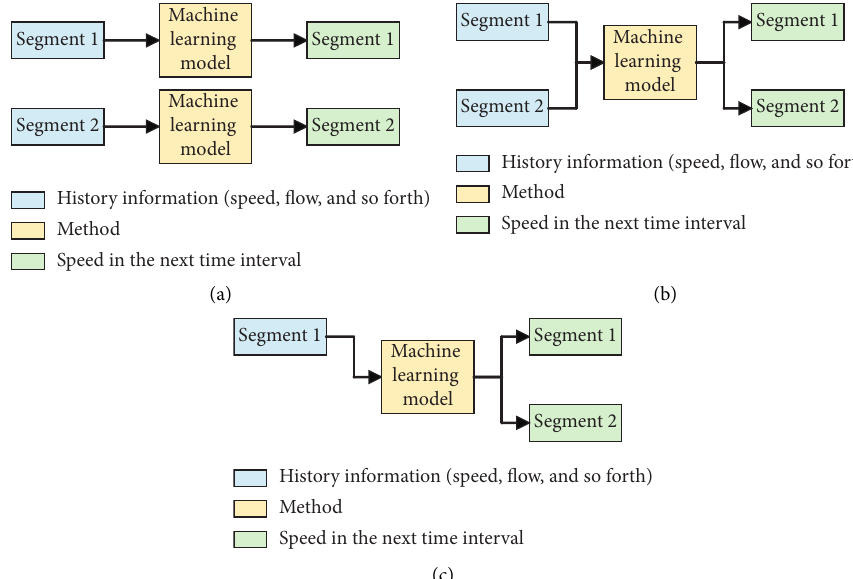
Figure 1: The implementation scene of the algorithms for vehicle speed